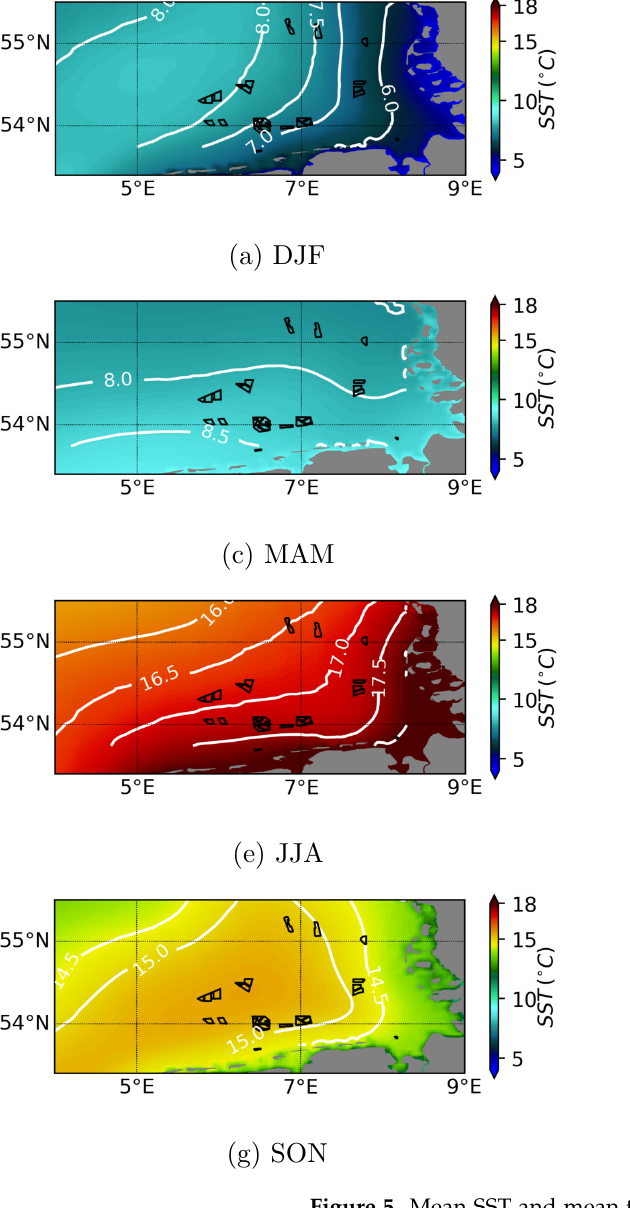
Figure 5. Mean SST and mean thermal stability for the seasons in ( a , b ) winter (DJF), ( c , d ) spring (MAM), ( e , f ) summer (JJA) and ( g , h ) autumn (SON) from DWD for the period 2017–2020. The black polygons represent the wind farm